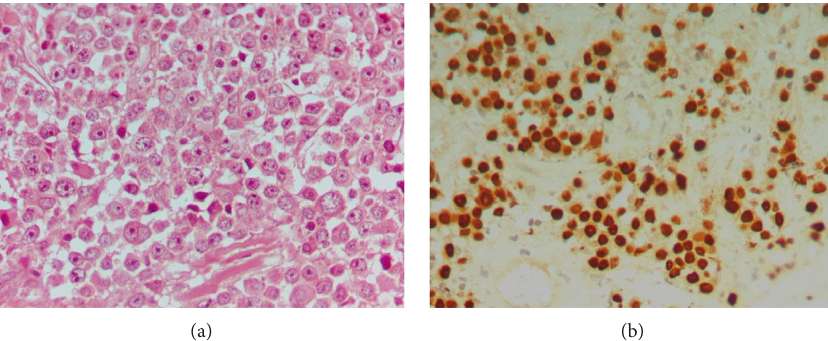
Figure 1: Plasmablastic lymphoma. The tumor cell was large with prominent nucleoli (a) (H&E staining, magnification × 600) and positive for Epstein–Barr virus by in situ hybridization with the EBER probe (b) (DAB, magnification × 400). Table 1: Differential diagnosis of PBL by immunohistochemistry. Markers Case